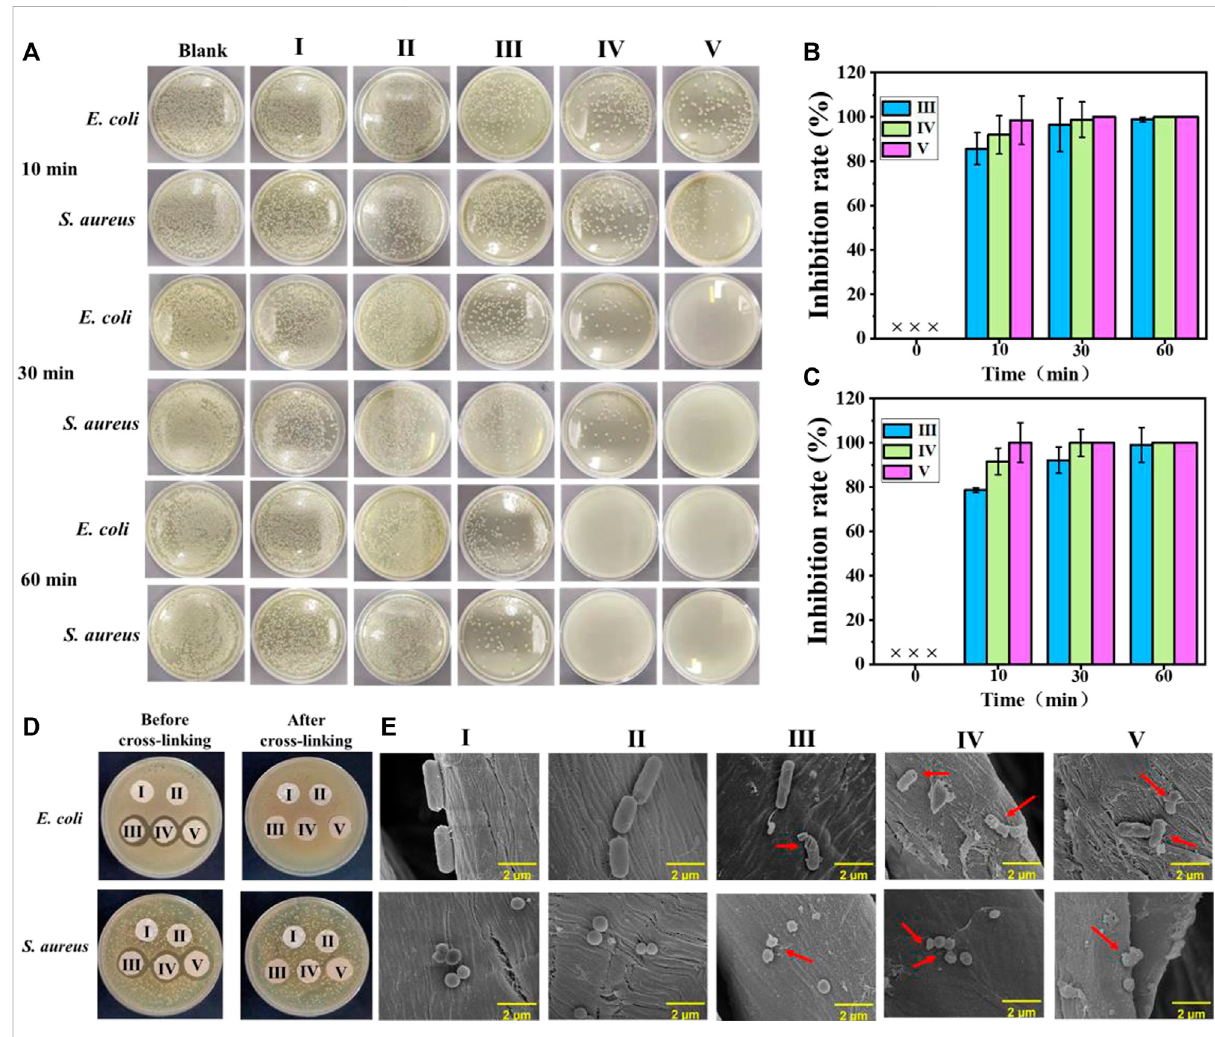
FIGURE 3 (A) Photographs showing antimicrobial activities of coated cotton fabrics against E. coli and S. aureus after different contact times; the sterilization rate histogram of the coated cotton fabric against E. coli (B) and S. aureus (C) ; (D) inhibition zone of the coated cotton fabric before and aftercross-linkingagainst E.coli and S.aureus ;andSEMimagesof E.coli and S.aureus intheuncoatedandcoatedcottonfabricgroups (E)